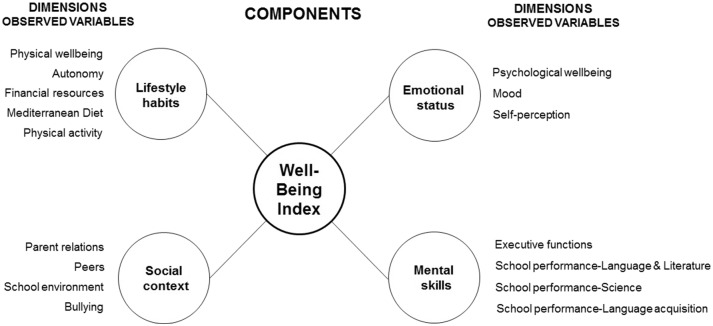
Conceptual framework for Well-Being Index (WBI).